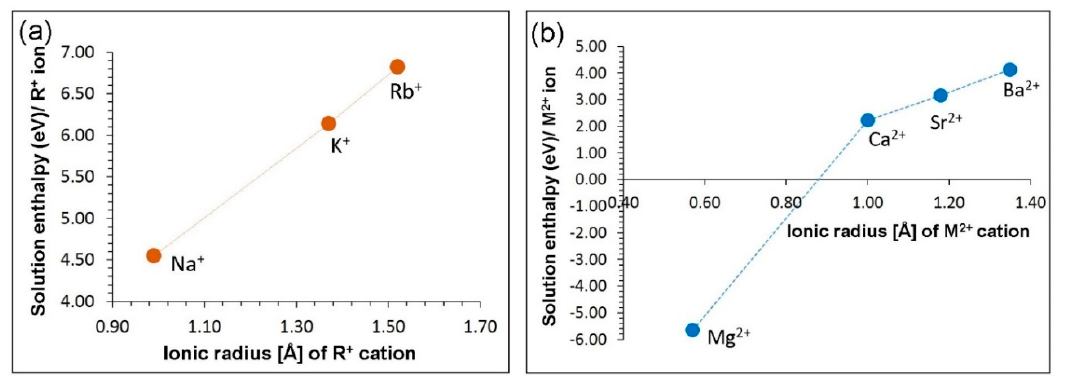
Figure 4. Solution enthalpies of (a) R 2 O (R = Na, K and Rb) with respect to the R + ionic radius and ( b ) MO (M = Mg, Ca, Sr and Ba) with respect to the M 2+ ionic radius in LiAlO 2 .